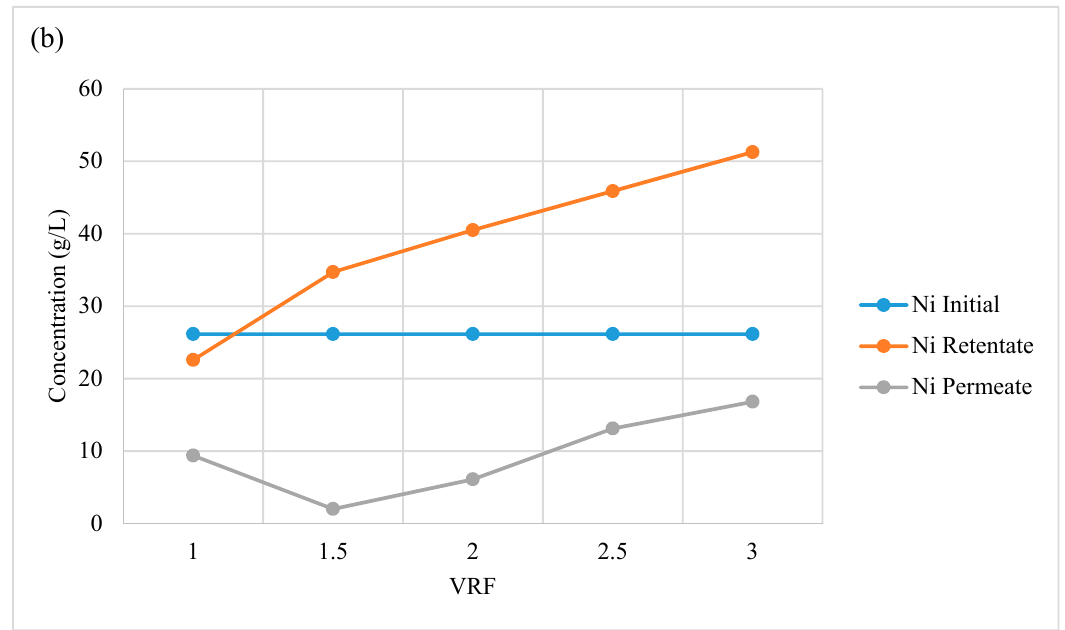
Figure 8. Concentration of metal ions in the retentate and permeate streams in experiment N2: ( a ) Co and Mn and ( b ) Ni.